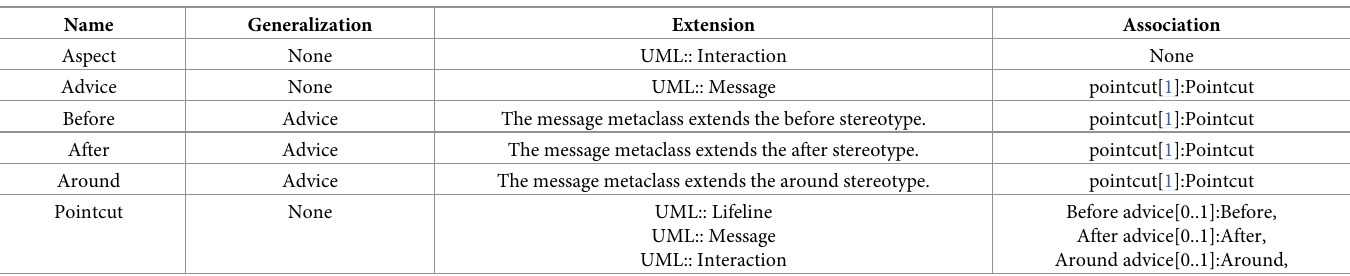
Table 4. AOM profile table.